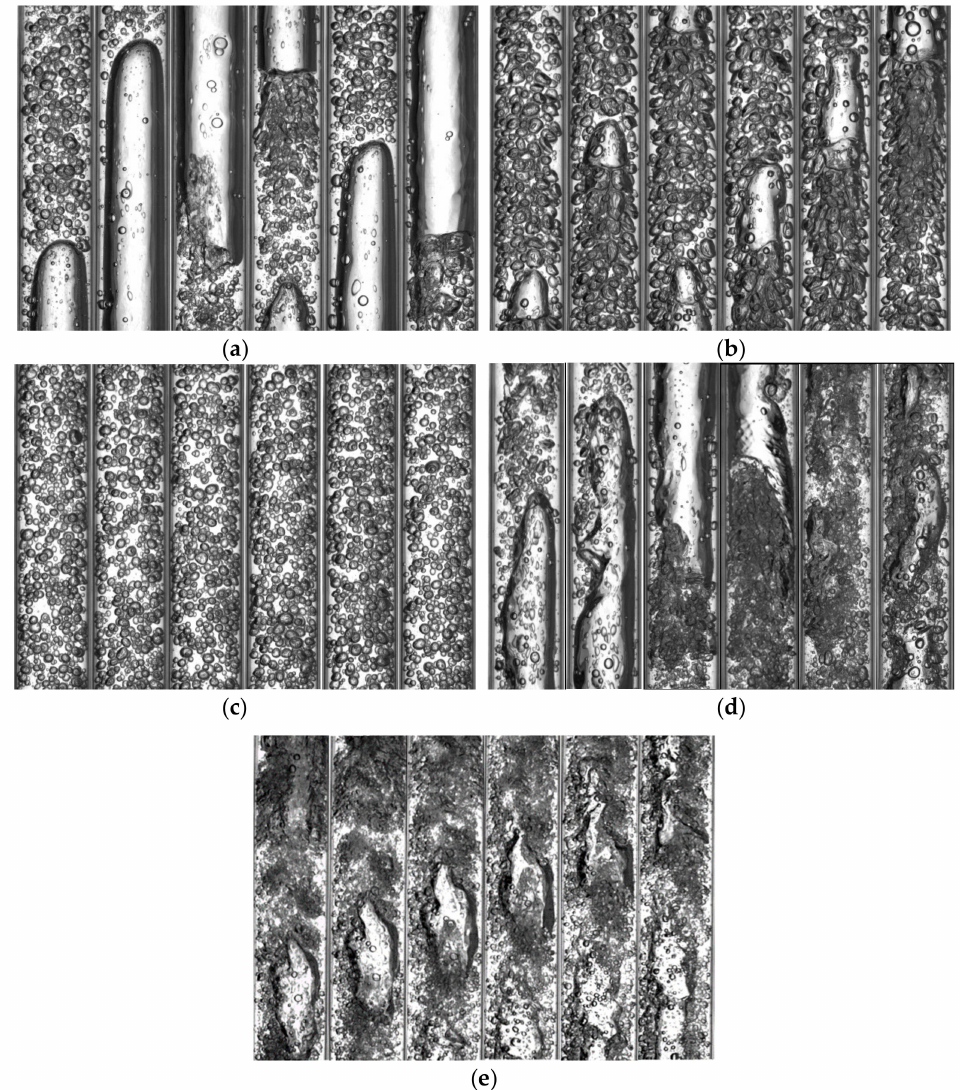
Figure 5. Visualizations of experimental flow patterns, and the interval of each frame is 25 ms. ( a ) Slug flow ( U sg = 0.0552 m / s, U sw = 0.0368 m / s); ( b ) Bubble-slug transitional flow ( U sg = 0.0552 m / s, U sw = 0.5888 m / s); ( c ) Bubble flow ( U sg = 0.0552 m / s, U sw = 1.1776 m / s); ( d ) Slug-churn transitional flow ( U sg = 0.4416 m / s, U sw = 0.5888 m / s); ( e ) Churn flow ( U sg = 0.4416 m / s, U sw = 1.1776 m /